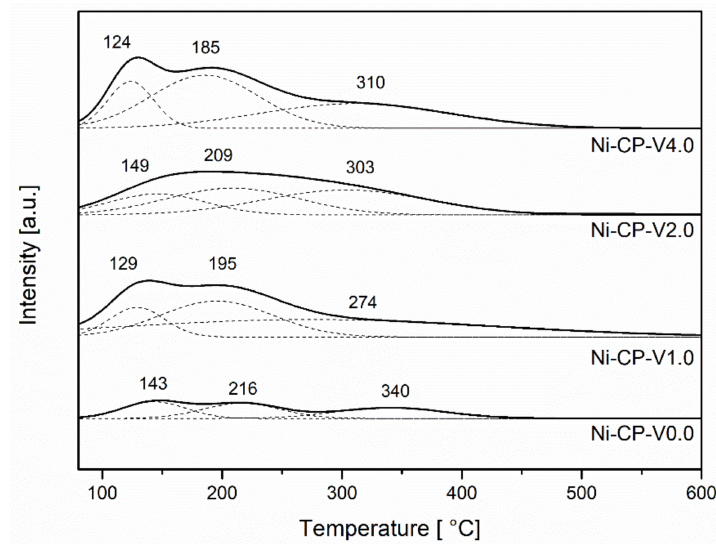
Figure 5. CO 2 -TPD profiles for reduced hydrotalcites.